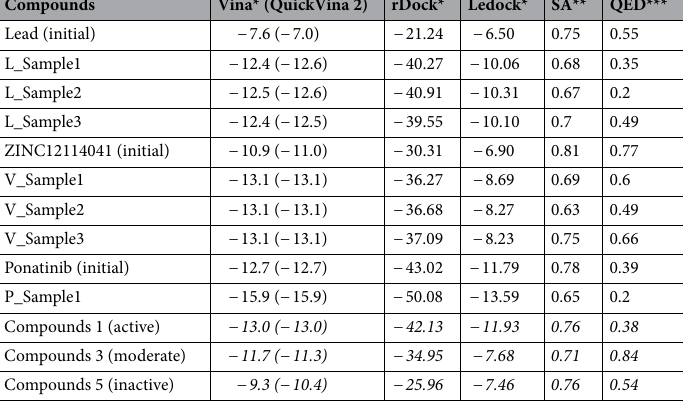
Table 1. Docking scores calculated by four popular docking programs (AutoDock Vina, QuickVina 2, rDock, Ledock), as well as SA and QED scores for the DDR1 inhibitors. Data in italics indicates compounds generated by Zhavoronkov et al. 8 . *For docking scores, the lower, the better. The unit of Vina, QuickVina 2, and Ledock score is kcal/mol. **Synthetic accessibility. ***Quantitative Estimate of Drug-likeness.